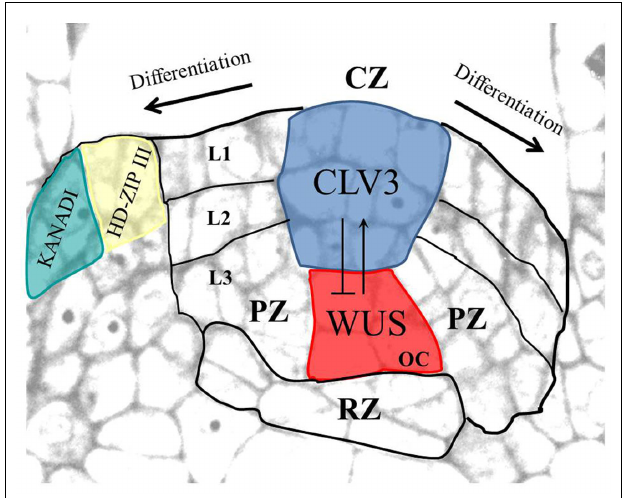
FIGURE 1 |Arabidopsis shoot apical meristem organization. The shoot meristem with the central zone (CZ), the peripheral zone (PZ), and the rib zone (RZ) is shown.The three layers (L1–L3) are indicated. Stem cells (shown in blue, expressing CLV3 ) and the organizing center (OC; shown in red, expressing WUS ) interact in a negative feedback loop. In the leaf primordium, adaxial and abaxial cell fates are marked by expression of HD-ZIP III and KANADI family genes, respectively. Modified from Gross-Hardt and Laux (2003).